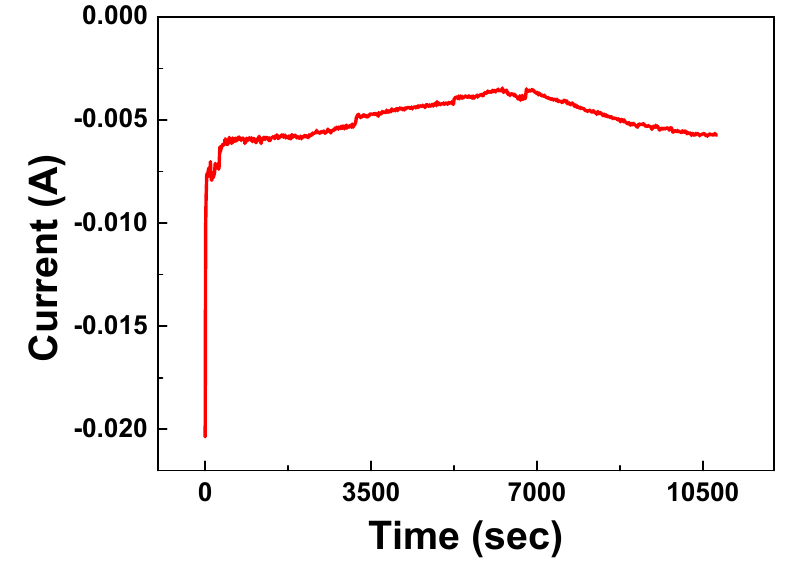
Figure 6. Chronoamperometric curve during mediated electrocatalytic reduction of allyl chloride. Conditions: working solution (250 ml) = 5 mM allyl chloride+ 1 mM [Co(II)(bpy) 3 ] 2+ + 100 mM BKC in 0.1 M Na 2 SO 4 solution; Electrodes = Carbon cathode and Pt anode; Applied potential = − 1300 mV.